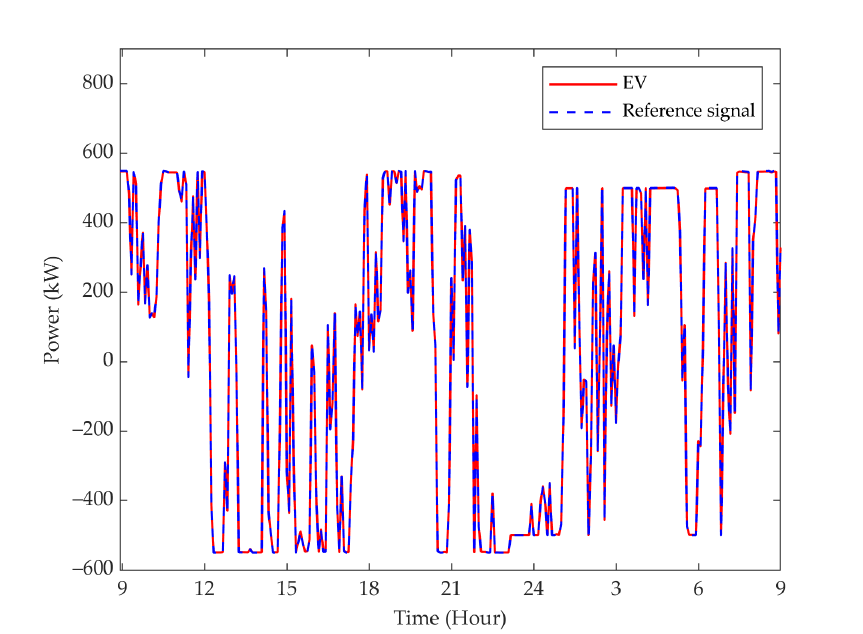
Figure 12. The 500 EV s charging and discharging profile for frequency regulation in Scenario